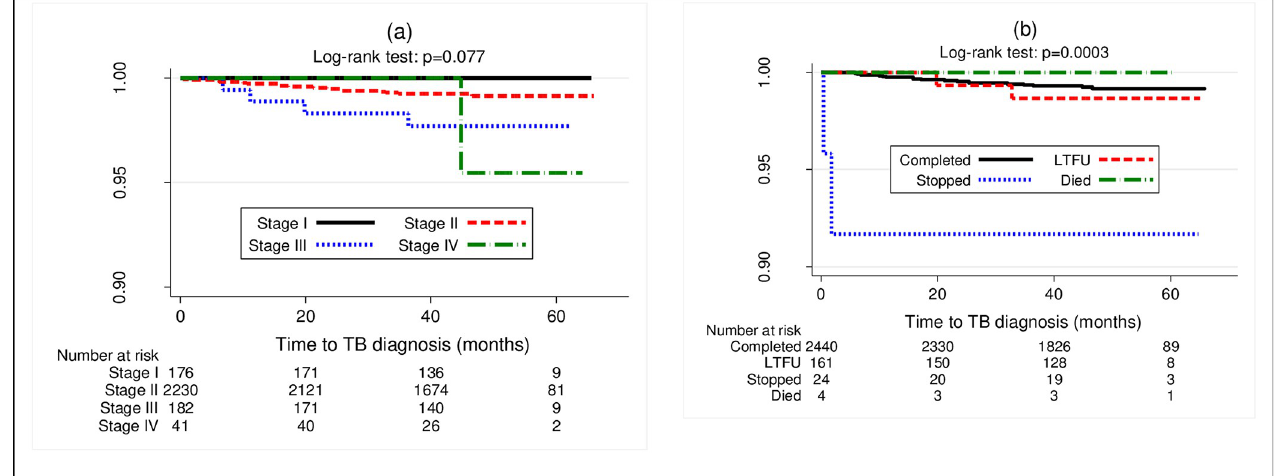
Fig 1. Kaplan Meier curves showing proportion surviving from TB infection by WHO HIV clinical stage (panel a) and IPT outcomes (panel b).